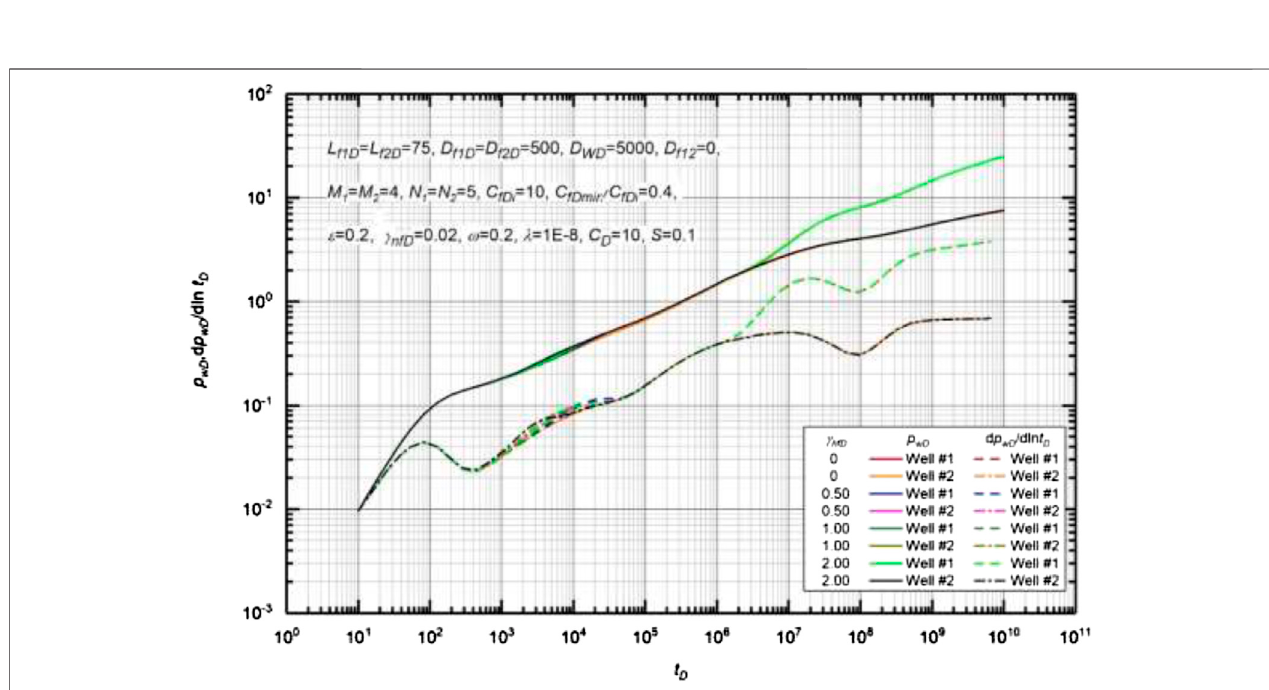
FIGURE 8 | Effect of HF permeability modulus on the transient pressure for MWPMF.